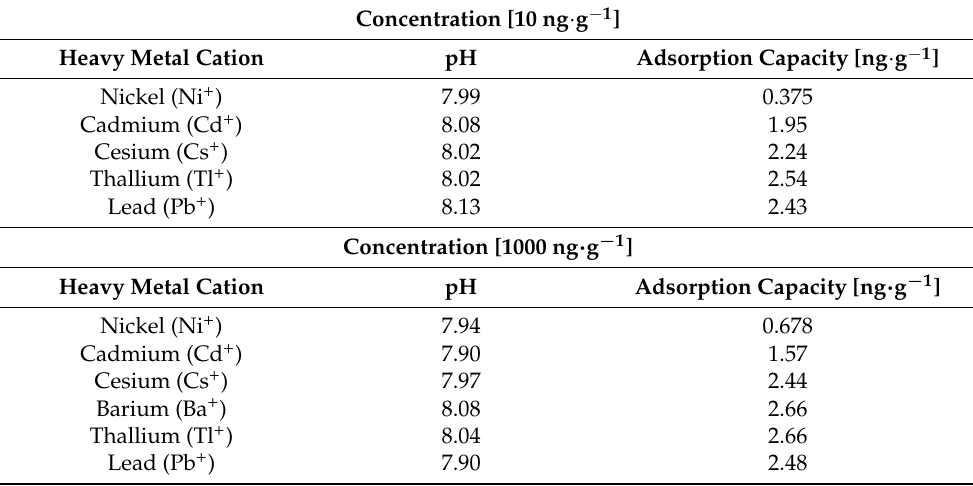
Table 5. Adsorption capacities, pH, and removal efficiencies for the adsorption of heavy metal ions by PCT for a contact time of 180 min for an amount of 0.2 g of